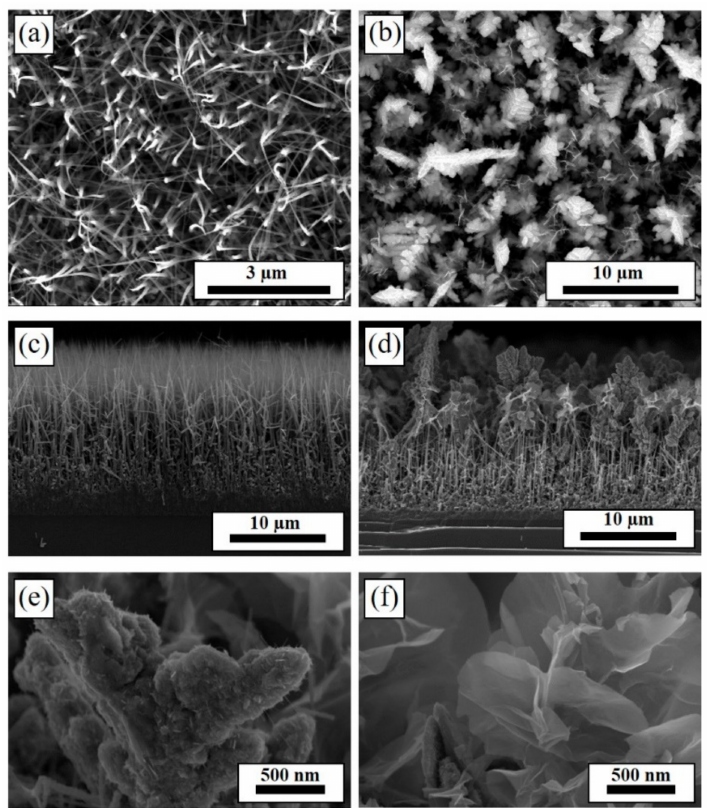
Figure 1. The top-view SEM images of the SiC NW film ( a ) before and ( b ) after Co 3 O 4 decoration; their corresponding cross-section SEM images are shown in ( c , d ), respectively. ( e , f ) Are the high- magnification cross-section SEM images of the top side of ( d ).